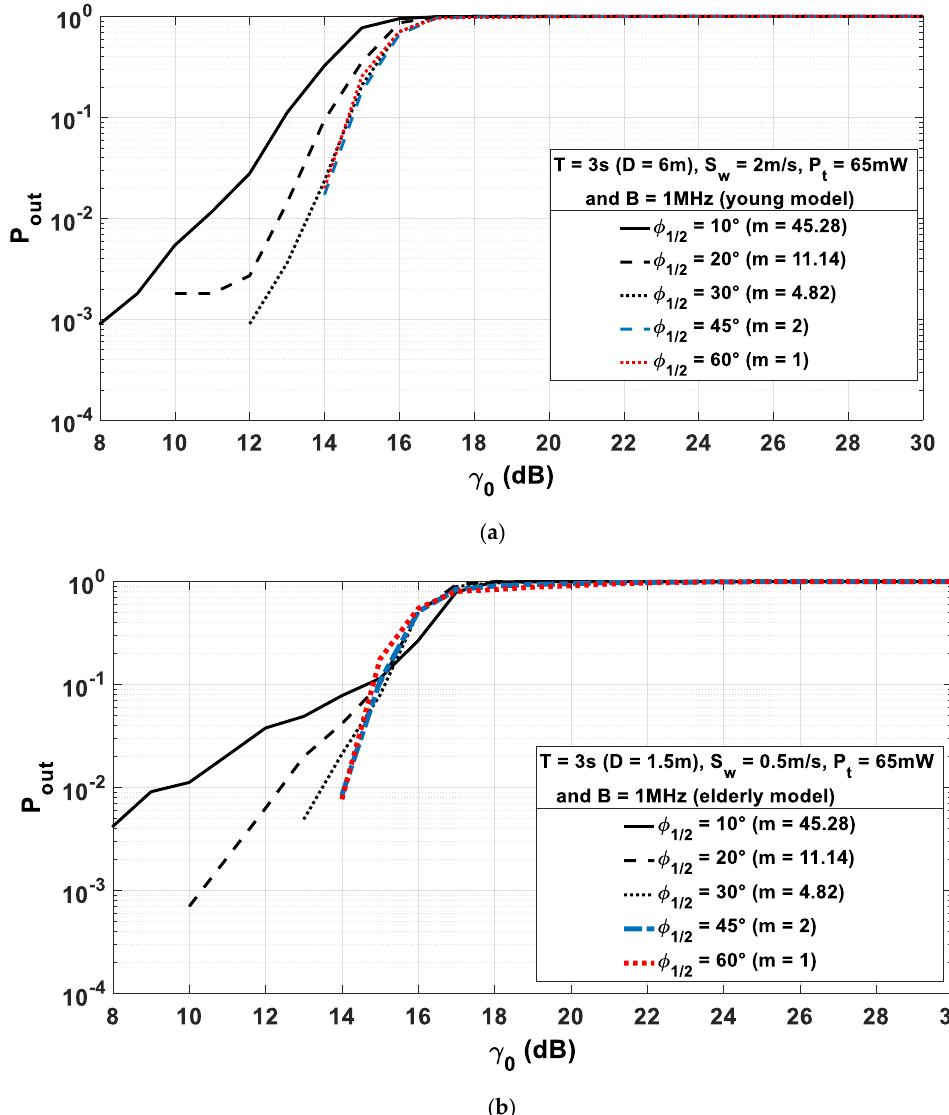
Figure 14. Outage probability 𝑃 𝑜𝑢𝑡 as a function of 𝛾 0 for different values of 𝜑 1/2 : with young model ( a ) and with elderly model ( b ).